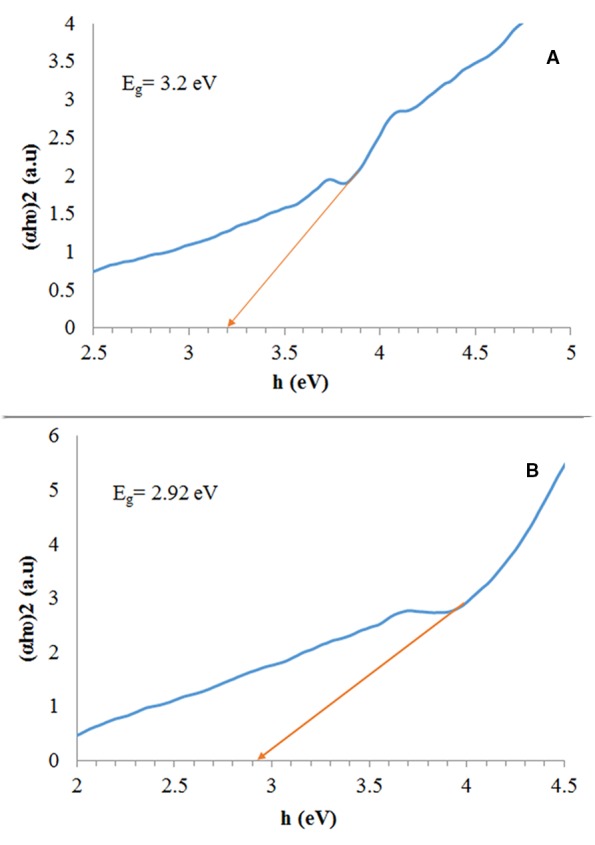
Plot of (αhυ)12vs. energy (hυ) of N1 sample (A) and N5 sample (B).